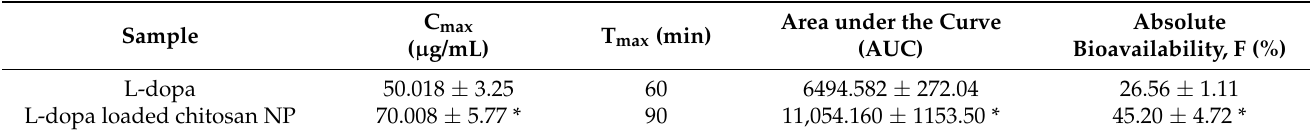
Table 3. Pharmacokinetic profiles of 2.5 mg/kg L-dopa and 2.5 mg/kg L-dopa loaded chitosan nanoparticles (formulation C2) after intranasal administration. Results are expressed as the mean ± S.E. of 3 replicates; * p <